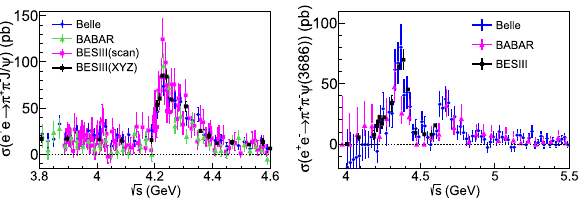
Fig. 1 Cross sections of e + e − → π + π − J /ψ (left) and e + e − → π + π − ψ( 3686 ) (right) from Belle, BABAR and BESIII experiments